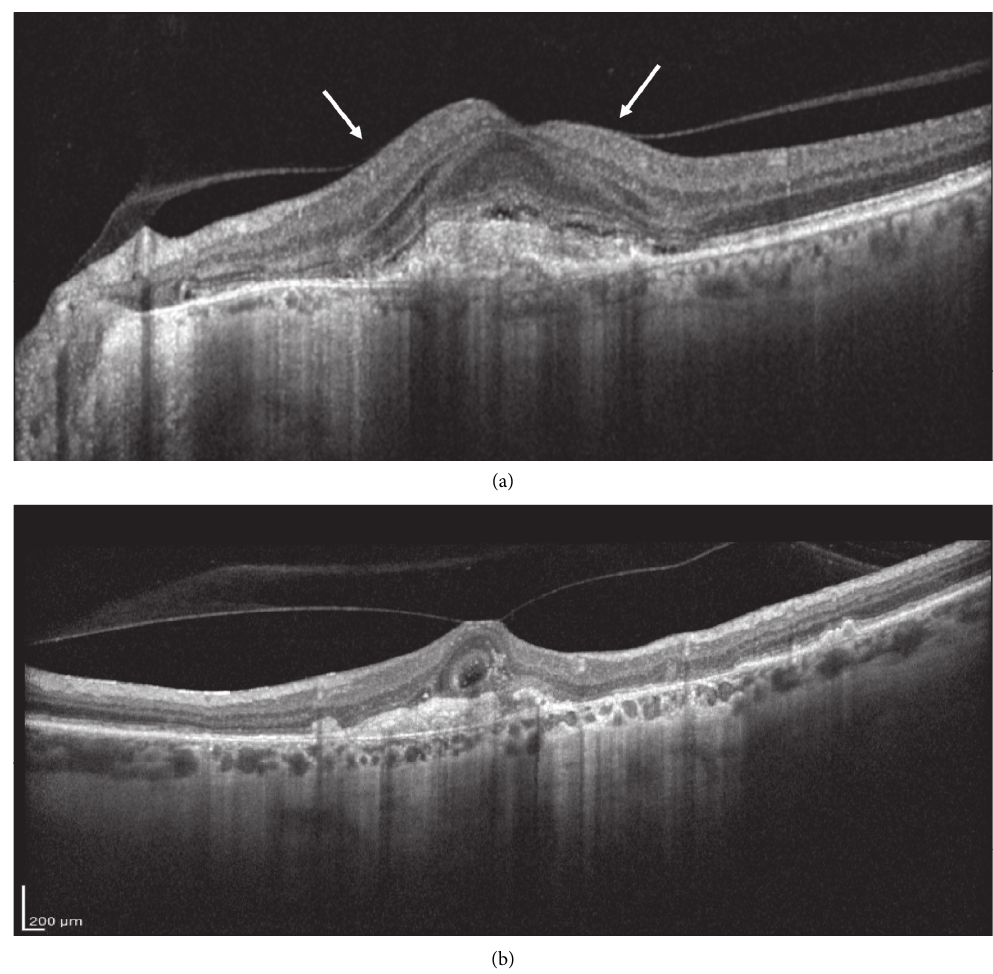
Figure 7: Structural OCT biomarker: (a) vitreomacular adhesion (VMA, white arrows). The posterior hyaloid is partially detached, with a continuous adhesion on the foveal surface; (b) vitreomacular traction. The posterior hyaloid is fully detached but a foveal adhesion is present on the fovea with an evident